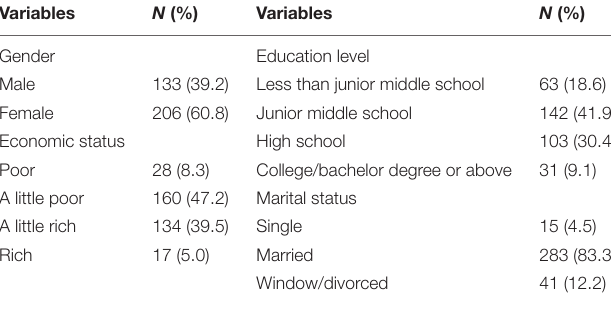
TABLE 1 | Demographic characteristics of